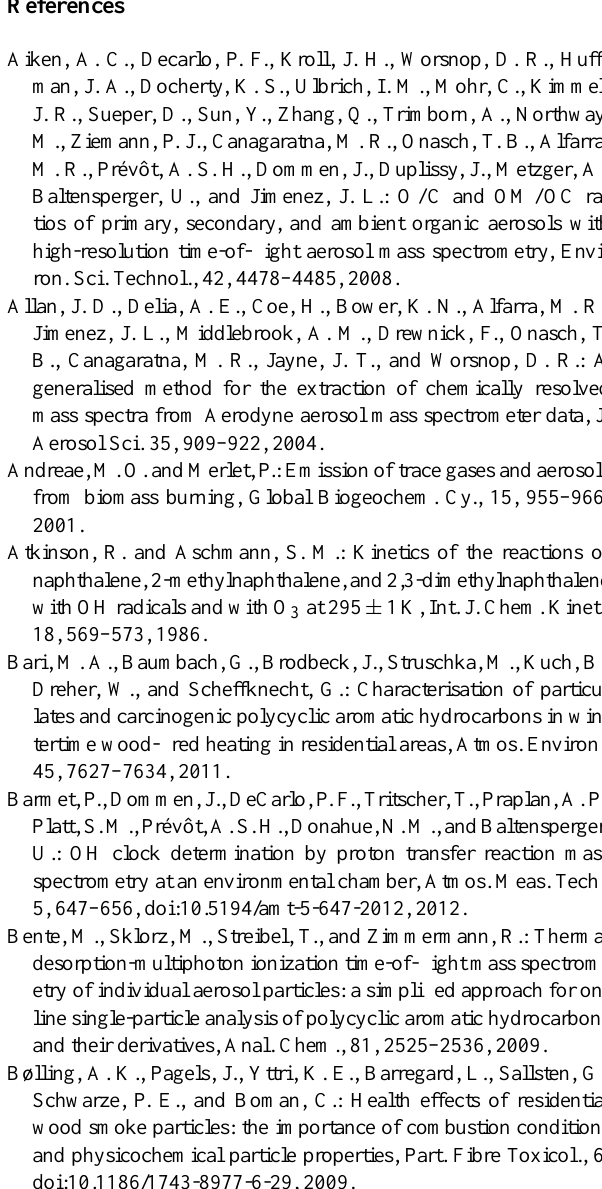
as a function 2